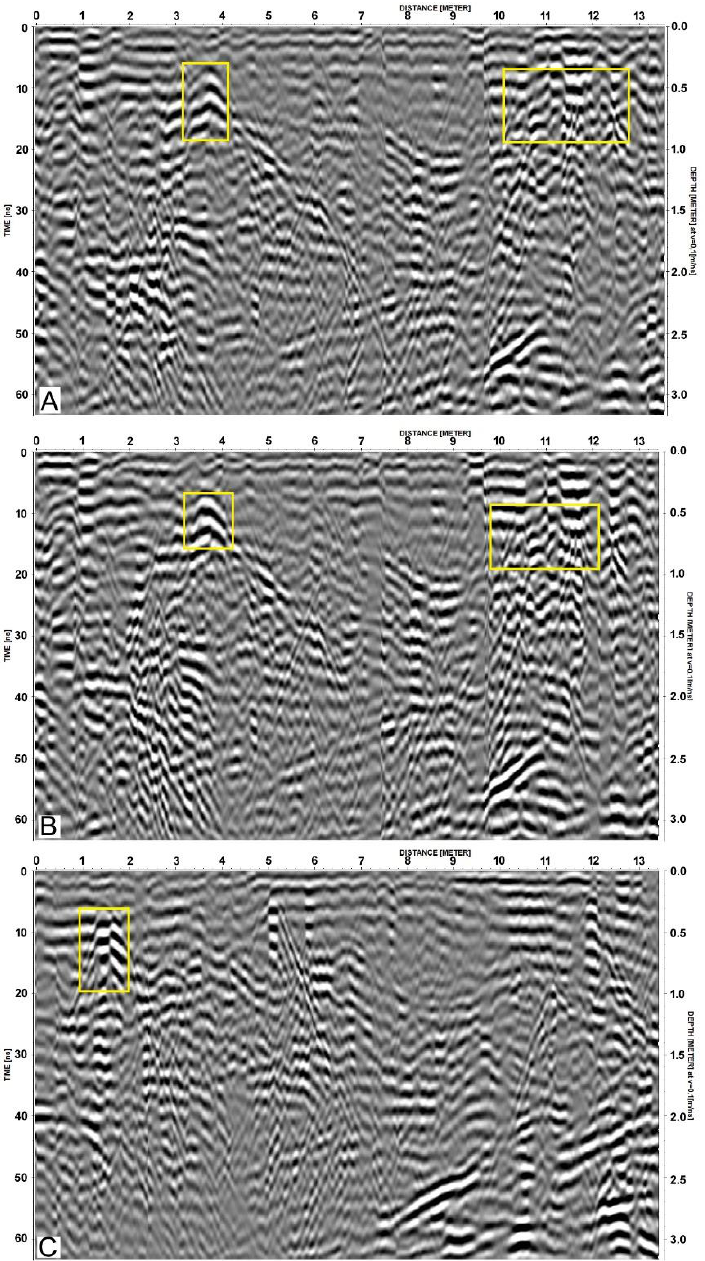
Figure 8. GPR reflection profile from GPR 1 area, X3M device with shielded antenna 500 MHz. Yellow rectangle marks anomalous zones: ( A ) profile 1; ( B ) profile 2; ( C ) profile 3.